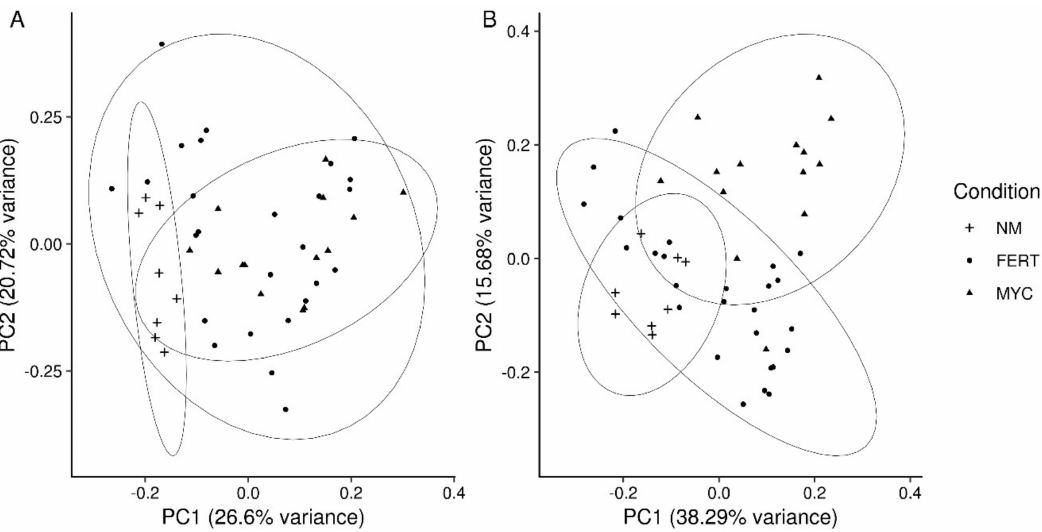
Figure 5. Principal Component Analysis (PCA) of the tomato fruits glycome under mycorrhizal (MYC), fertilized (FERT), and non-mycorrhizal (NM) conditions. ( A ) Analysis of the CDTA-extracted fraction; ( B ) Analysis of the NaOH-extracted fraction. The first two components, clustered by condition, were plotted, and 95% confidence ellipses were drawn ( n =